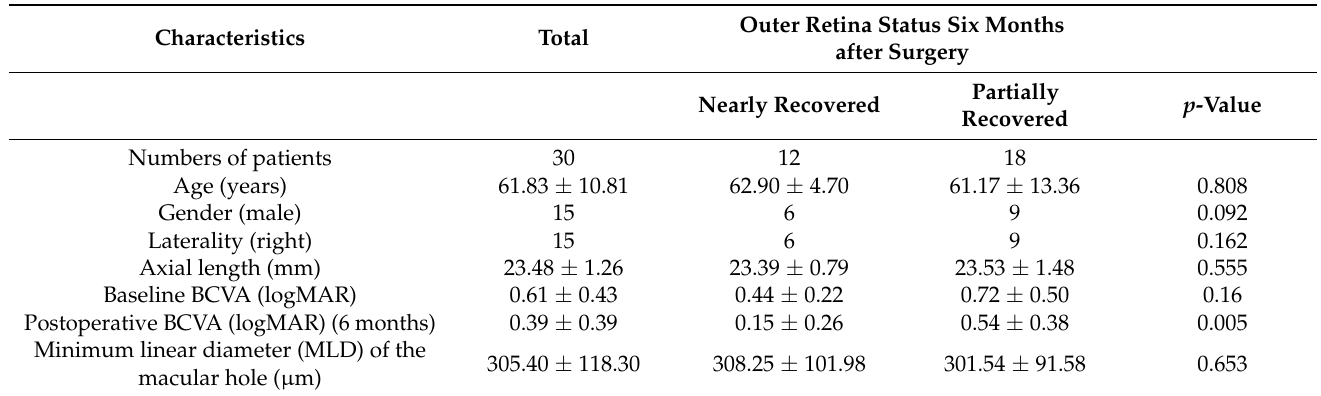
Table 1. Demographics and clinical characteristics of